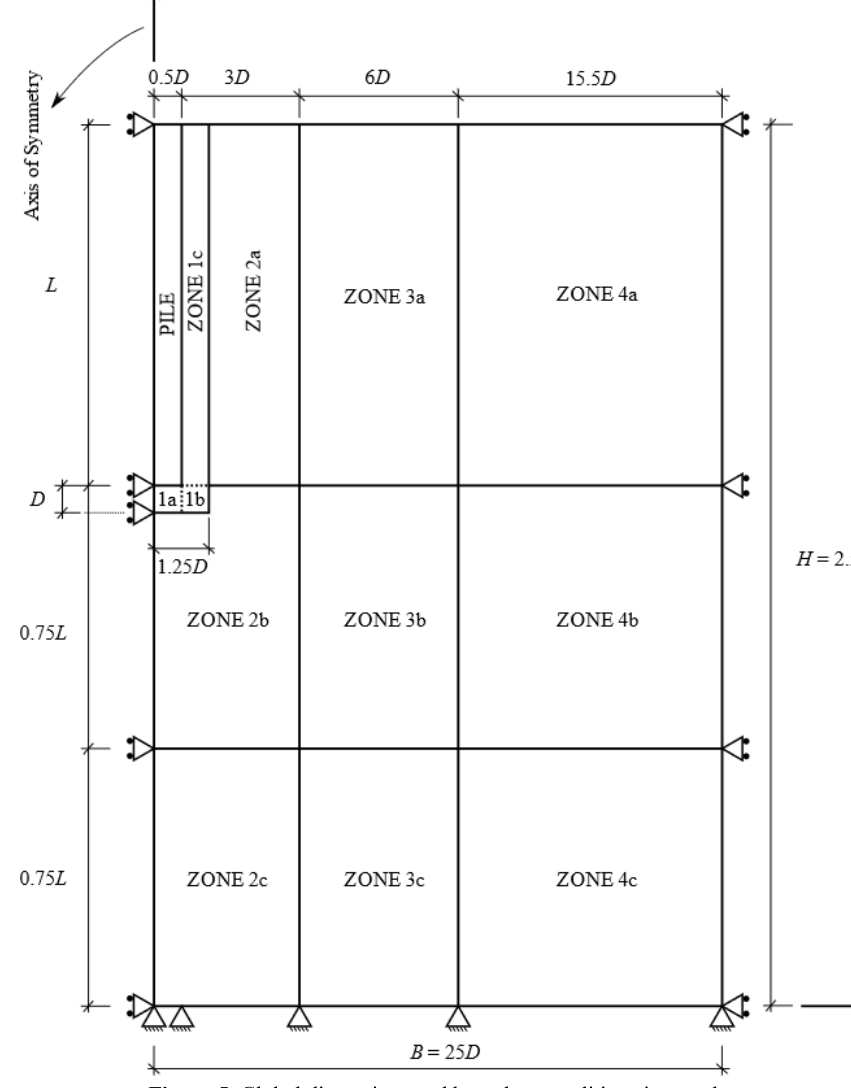
Figure 5. Global dimensions and boundary conditions in r – z